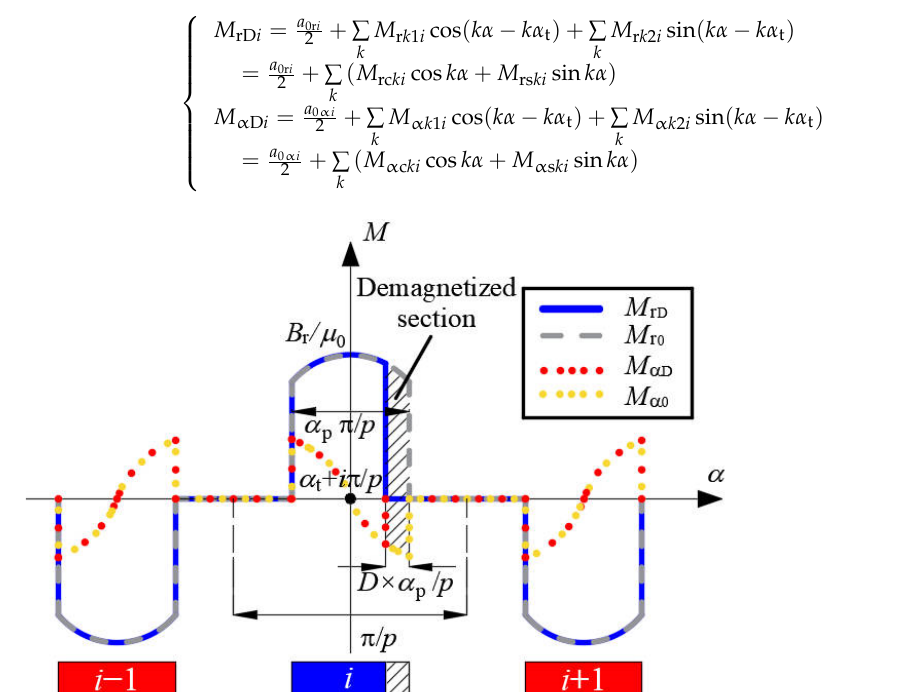
The waveforms of radial and tangential components of the magnetization for healthy PMs and partially demagnetized PMs are shown in Figure 7.